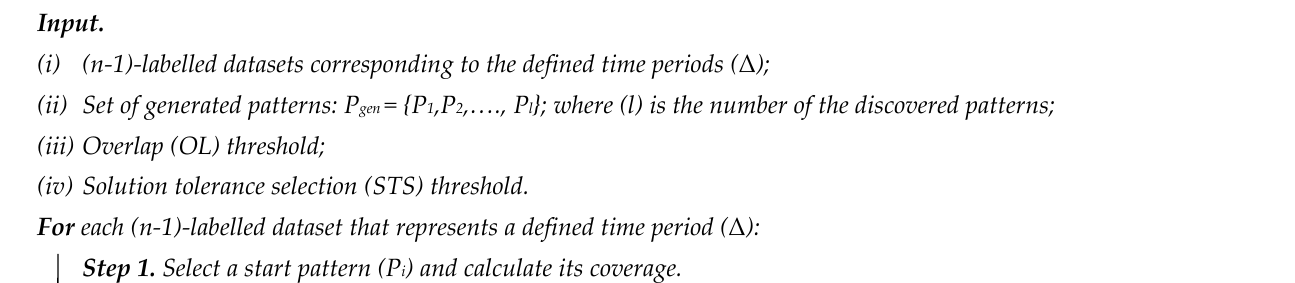
Algorithm 1. Time-based searching algorithm: Search for similar feasible solutions over time . Time-based searching algorithm: Search for similar feasible solutions over